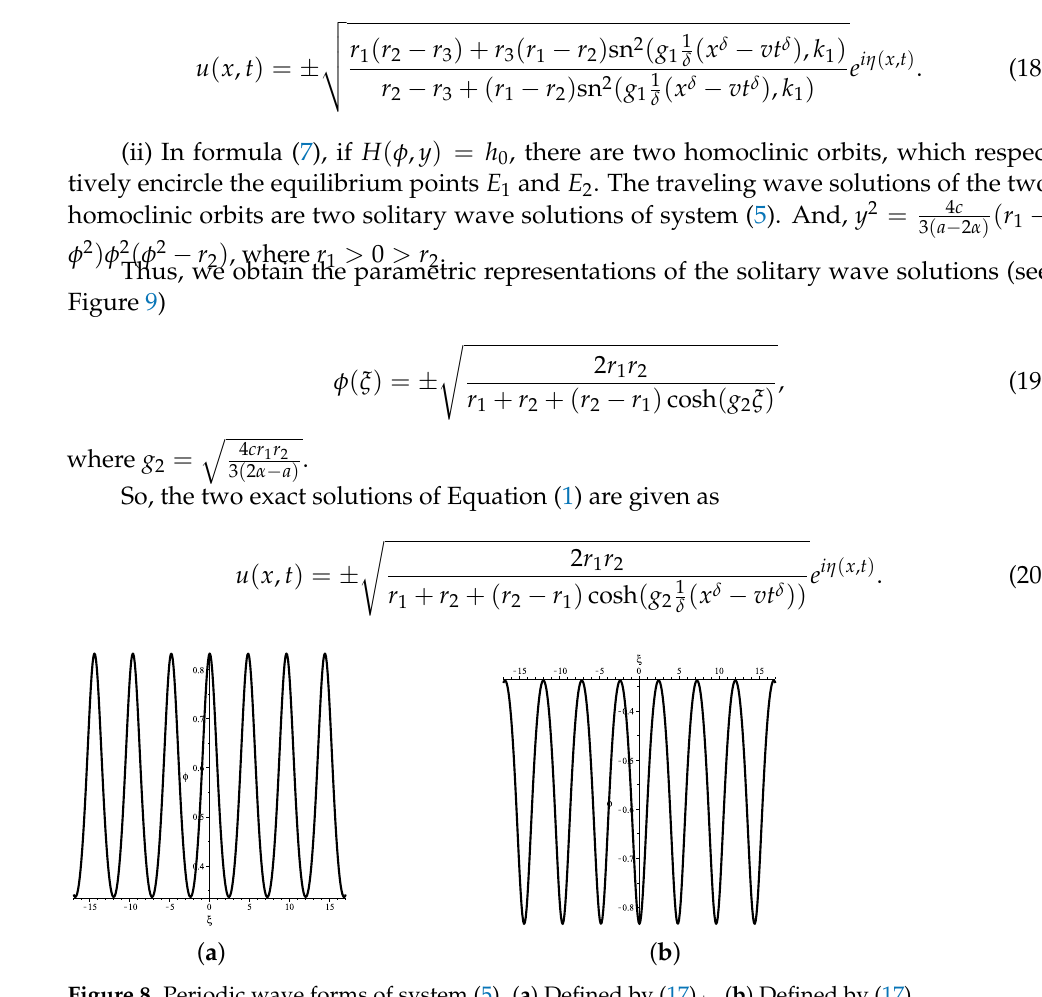
Figure 8. Periodic wave forms of system (5). ( a ) Defined by (17) + . ( b ) Defined by (17) − .